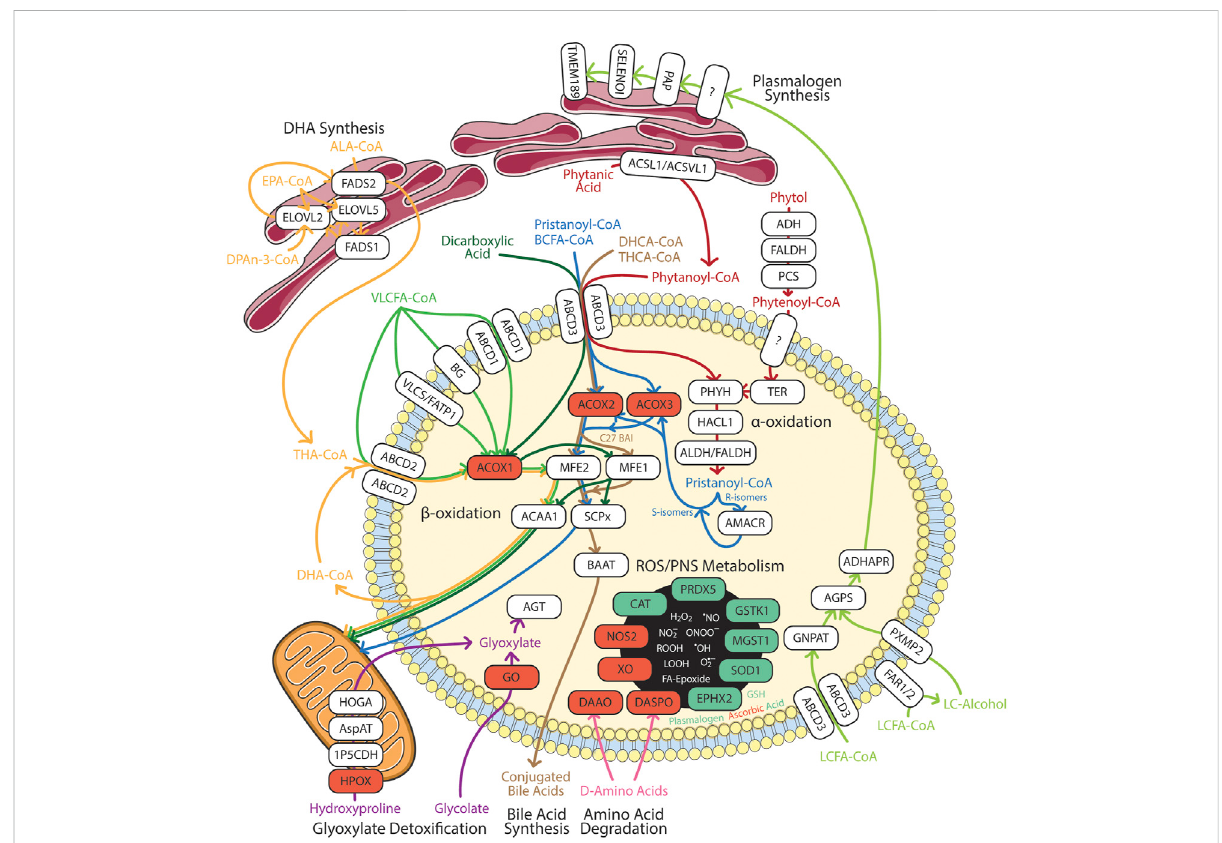
FIGURE 2 Summary of peroxisomal functions in humans. Enzymes involved in the catabolic and anabolic pathways in white boxes. Red box represents ROS/RNS producing enzymes. Green box represents anti-oxidation enzymes in redox homeostasis. 1P5CDH, Δ 1 -pyrroline-5-carboxylate dehydrogenase; ABCD, ATP-binding cassette sub-family D; ACAA, 3-oxoacyl thiolase; ACOX, acyl-CoA oxidase; ACSL, long chain acyl-CoA synthetase; ACSVL, very long chain acyl-CoA synthetase; ADH, alcohol dehydrogenase; ADHAPR, acyl/alkyl DHAP reductase; AGPS, alkyl- glycerone phosphate synthase; AGT, alanine:glyoxylate aminotransferase; ALA, α -linolenic acid; ALDH, aldehyde dehydrogenase; AMACR, α - methylacyl-CoA racemase; AspAT, aspartate aminotransferase; BAAT, bile acid-CoA:amino acid N-acyltransferase; BCFA, branched chain fatty acids; BG, bubblegum; CAT, catalase; DAAO, D-amino acid oxidase; DASPO, D-aspartate oxidase; DHA, docosahexaenoic acid; DHCA, 3 α ,7 α - dihydroxy-5 β -cholestanoic acid; DPAn-3, n-3 docosapentaenoic acid; ELOVL, fatty acid elongase; EPA, eicosapentaenoic acid; EPHX2, epoxide hydrolase 2; FADS, fatty acid desaturase; FALDH, fatty aldehyde dehydrogenase; FAR, fatty acyl-CoA reductase; FATP, fatty acid transport protein; GNPAT, glycerone-phosphate O-acyltransferase; GO, glycolate oxidase; GSH, glutathione; GSTK, glutathione transferase kappa; HACL, 2- hydroxyacyl-CoAlyase;HOGA,4-hydroxy-2-oxoglutaratealdolase;HPOX,hydroxyprolineoxidase;LCFA,longchainfattyacids;MFE,multifuctional enzyme; MGST, microsomal glutathioneS-transferase; NOS2, induciblenitric oxide synthase; PAP, phosphatidic acid phosphatase;PCS, phytenoyl- CoA synthetase; PHYH, phytanoyl-CoA 2-hydroxylase; PRDX5, peroxiredoxin 5; PXMP2, peroxisomal membrane protein 2; SELENOI, selenoprotein 1 (ethanolamine phosphotransferase 1); SCPx, SCP-2/3-ketoacyl-CoA thiolase; SOD1, superoxide dismutase; TER, trans-2-enoyl-CoA reductase; THA,tetracosahexaenoic acid; THCA, 3 α ,7 α , 12 α -trihydroxy-5 β -cholestanoic acid;TMEM189,plasmanylethanolaminedesaturase; VLCFA, very long chain fatty acids; VLCS, very long chain acyl-CoA synthetase; XO, xanthine oxidase. The Figure was partly generated using Servier Medical Art, provided by Servier, licensed under a Creative Commons Attribution 3.0 unported